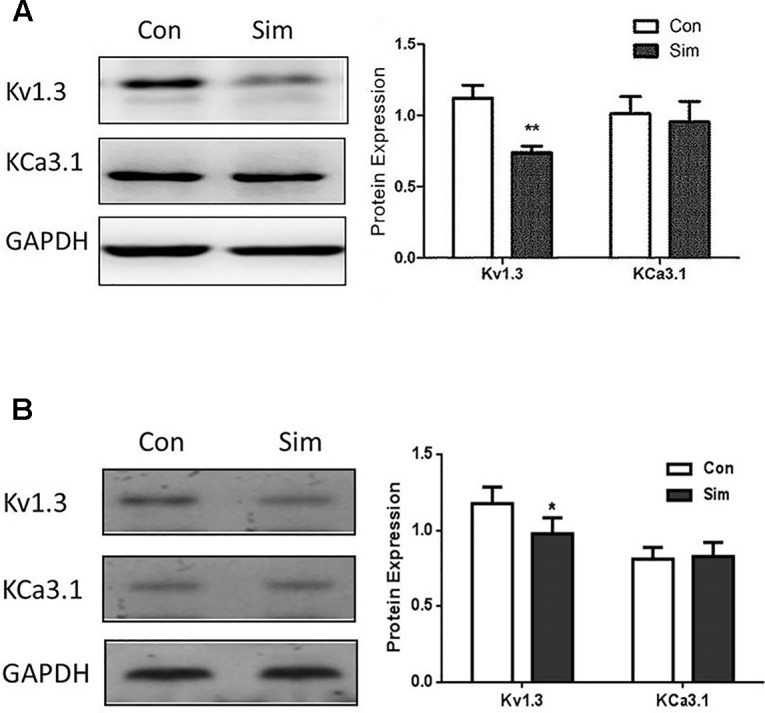
Protein expression levels of Kv1.3 and KCa3.1 in THP-1 cells (A) and PBMCs from CAD patients (B) were measured by western blot, respectively. (A) Representative western blot images of Kv1.3 and KCa3.1 levels in normal (control) and simvastatin treatment groups in THP-1 cells. The results were quantified, and represent the mean ± SEM, compared to controls (n = 4, **P < 0.01). (B) Representative western blot images of Kv1.3 and KCa3.1 levels in normal (control) and simvastatin treatment groups in PBMCs from CAD patients. The results were quantified, and represent the mean ± SEM, compared to controls (n = 4, *P < 0.05).